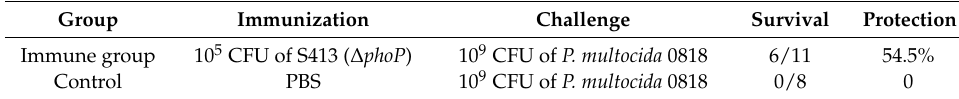
Table 3. Protection rate conferred by the ∆ phoP